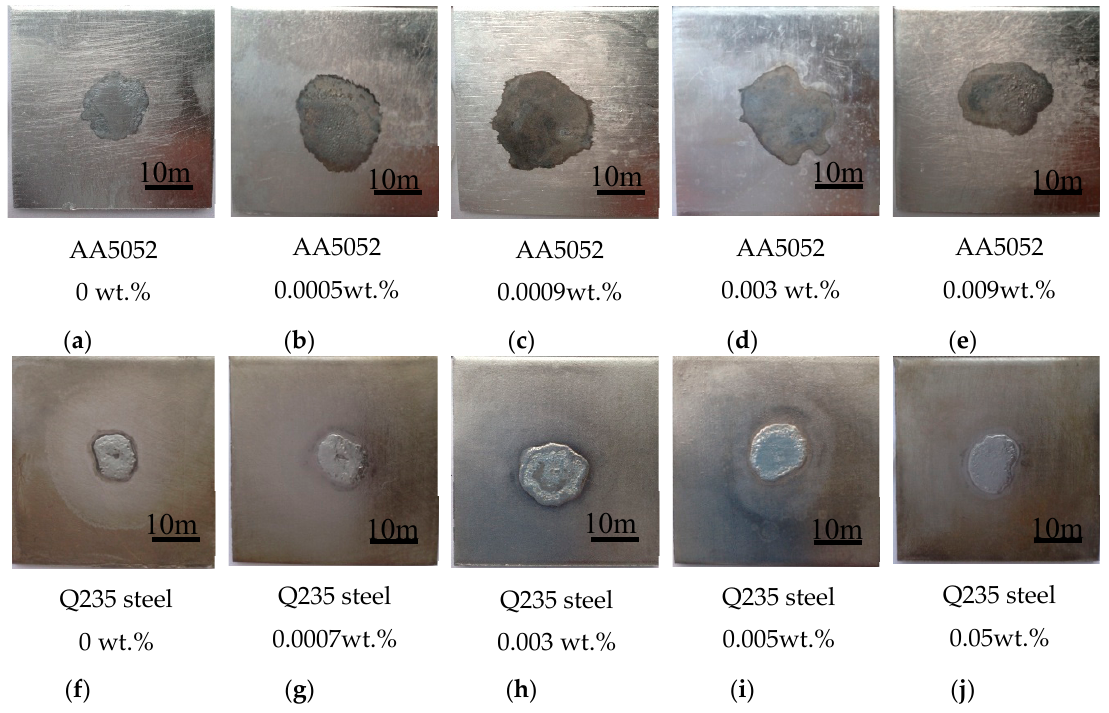
Figure 4. Spreading tests of Zn-2Al filler metal on base metals with CsF-RbF-AlF 3 -xGa 2 O 3 flux: ( a–e ) 5052 aluminum; ( f–i ) Q235 low-carbon steel.